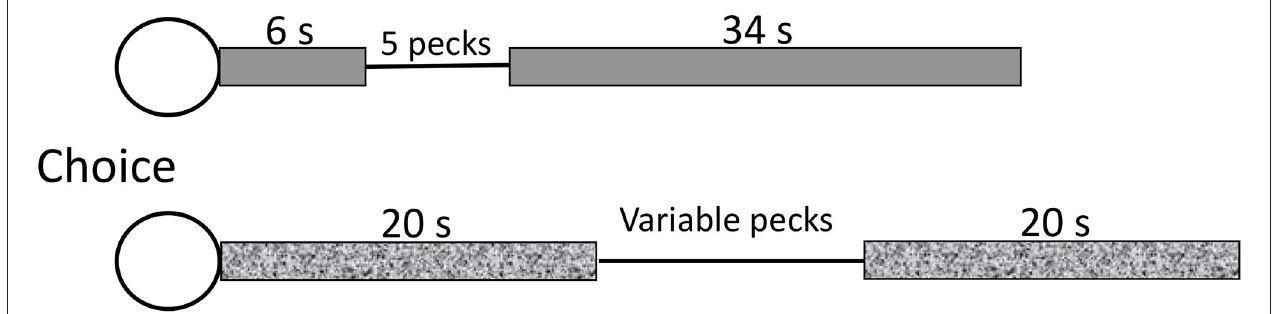
FIGURE 1 | After Mazur (1996). Pigeons were fed during the timed intervals on a variable time schedule (response independent). The variable response requirement was titrated until the pigeon was indifferent between the two chains. The measure of procrastination was the number of pecks required ( > 5) for the pigeons to be indifferent between the two